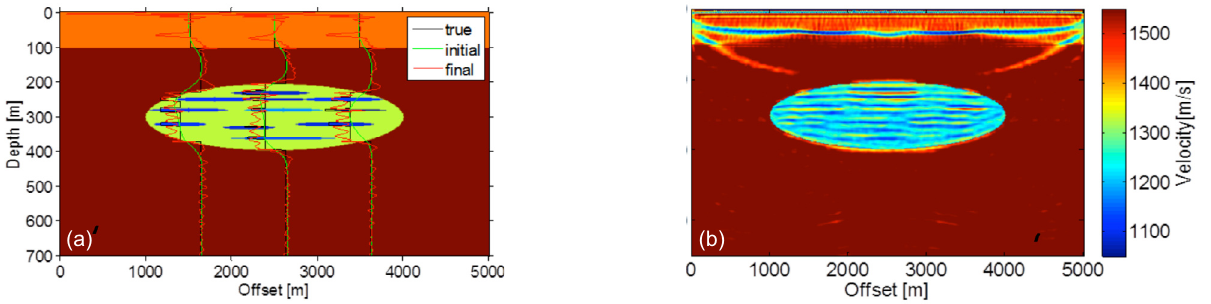
Figure 6. (a) Misfit plot with simultaneous source encoding (red color); (b) simultaneous source encoding inversion